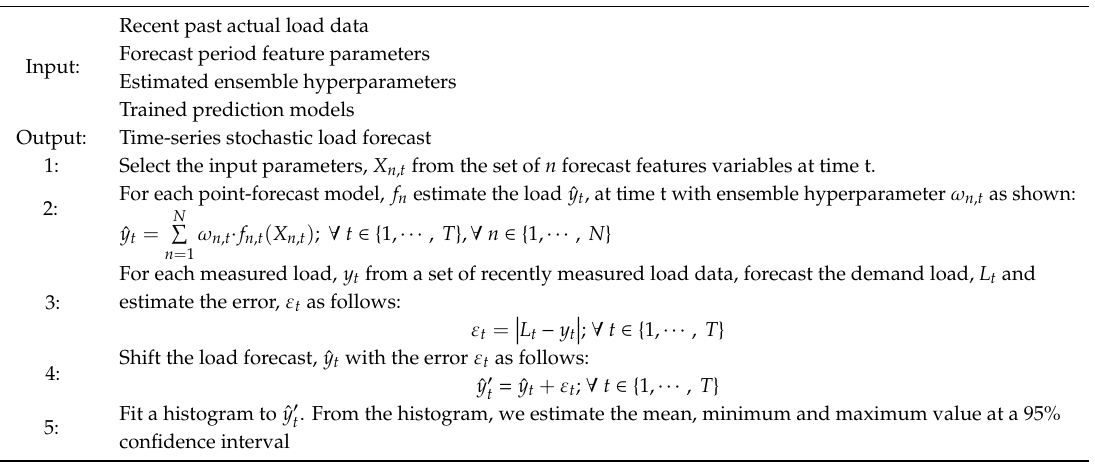
Algorithm 1: Algorithm for Stochastic Demand Load